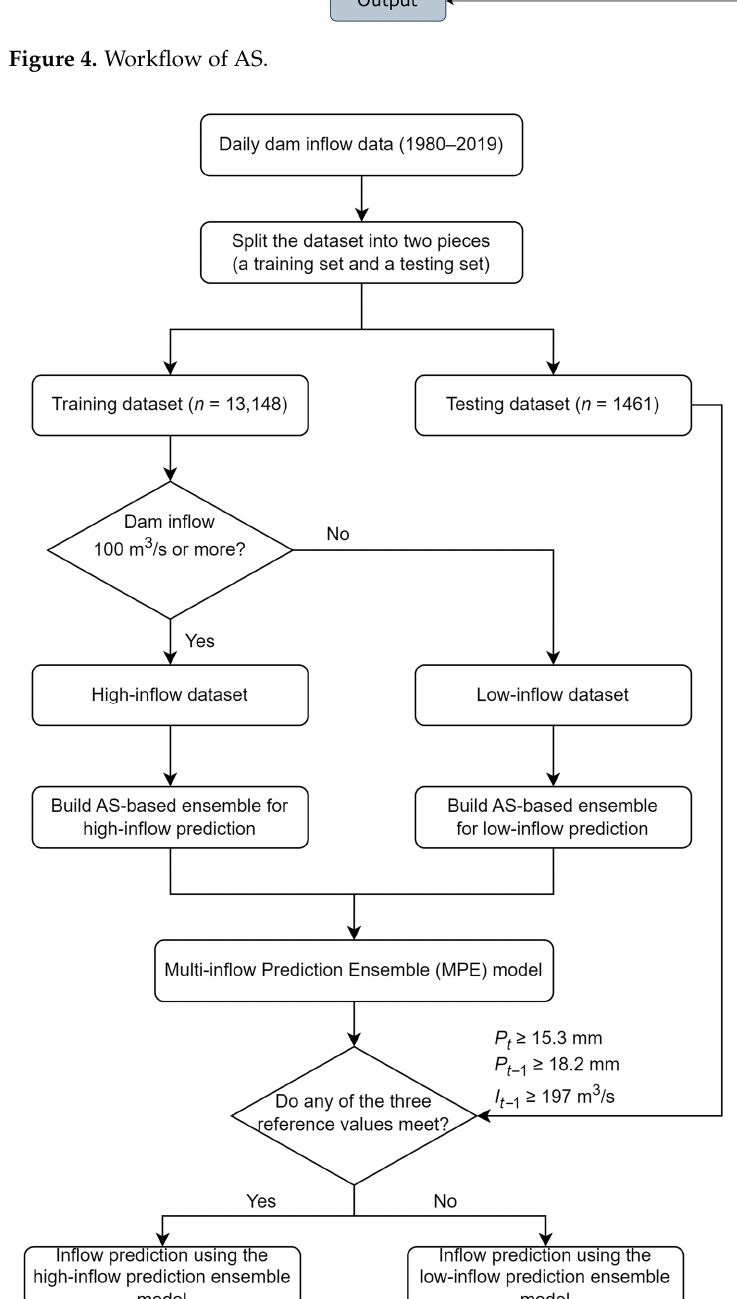
Figure 5. Development of the MPE model.